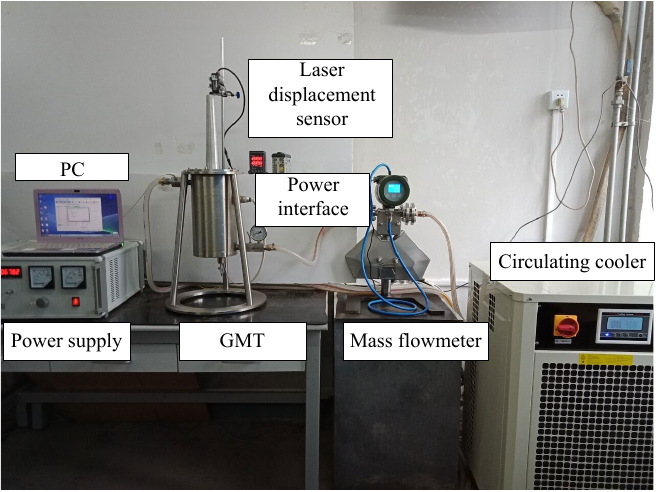
Figure 7. Temperature-control system of the GMT.